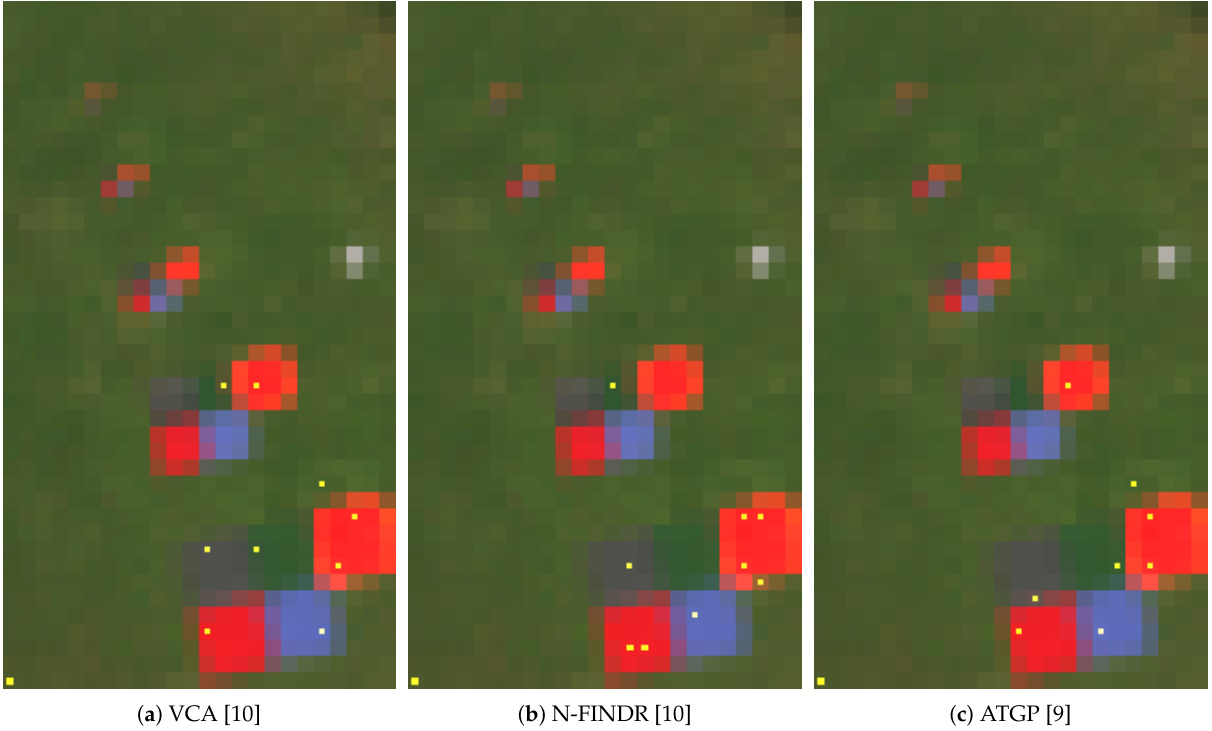
Figure 11. Locations of endmembers extracted from algorithms working under the pure pixel assumption on the subset All Targets Masked using as input number of endmembers k the best value between 6 and 10, indicated in brackets for each